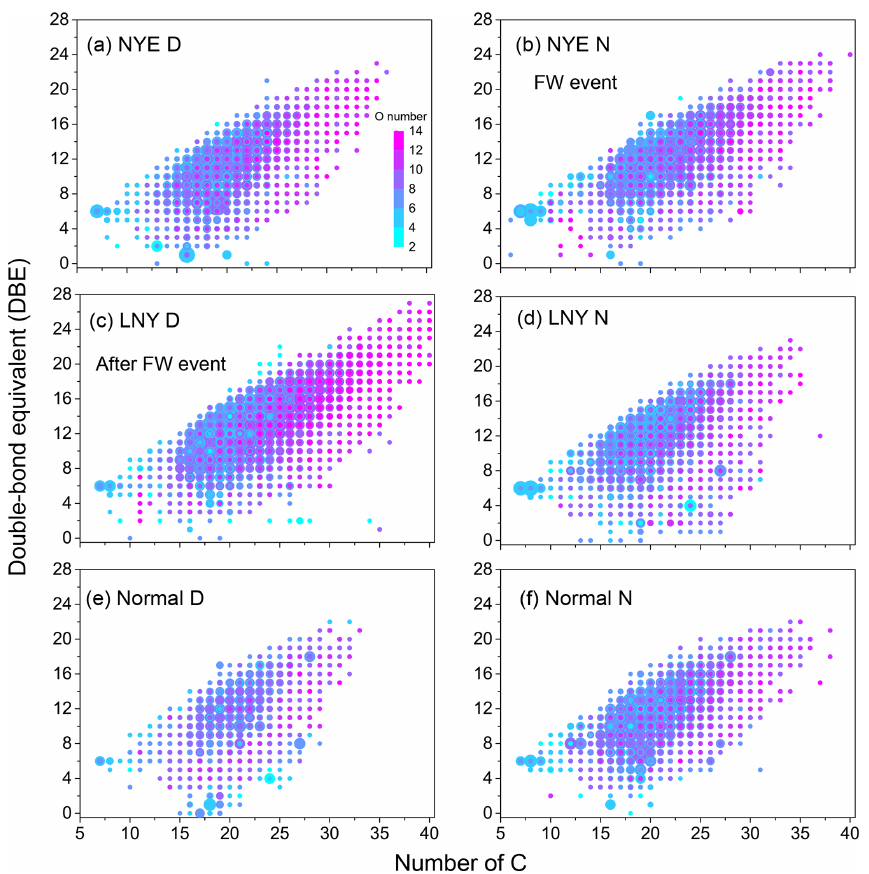
Figure 8. Double-bond equivalent (DBE) vs. number of C atoms for CHON species. The color bar denotes the number of O atoms. The size of the symbols reflects the relative peak intensities of molecular formulae on a logarithmic scale.